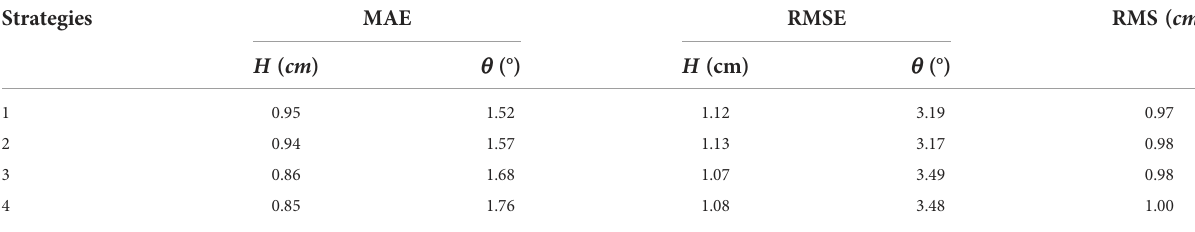
TABLE 3 Differences between SOs and re-estimated HCs obtained by inversion of